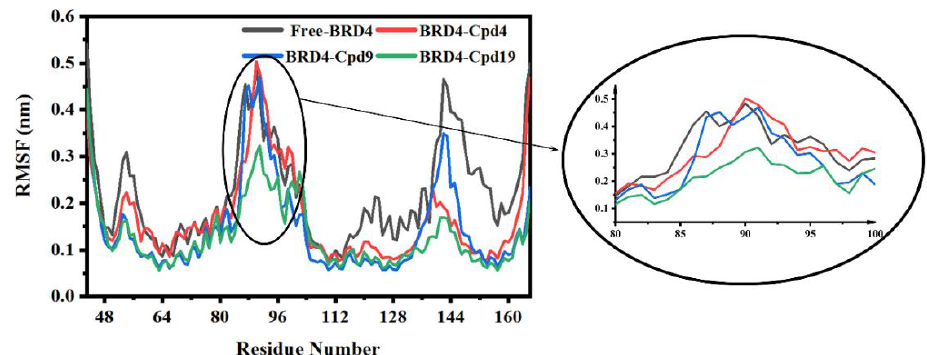
Figure 4. RMSF for the backbone atoms of the four systems. The free-BRD4 is represented in black, BRD4-Cpd4 is represented in red, BRD4-Cpd9 is represented in blue and BRD4-Cpd19 is represented in green.